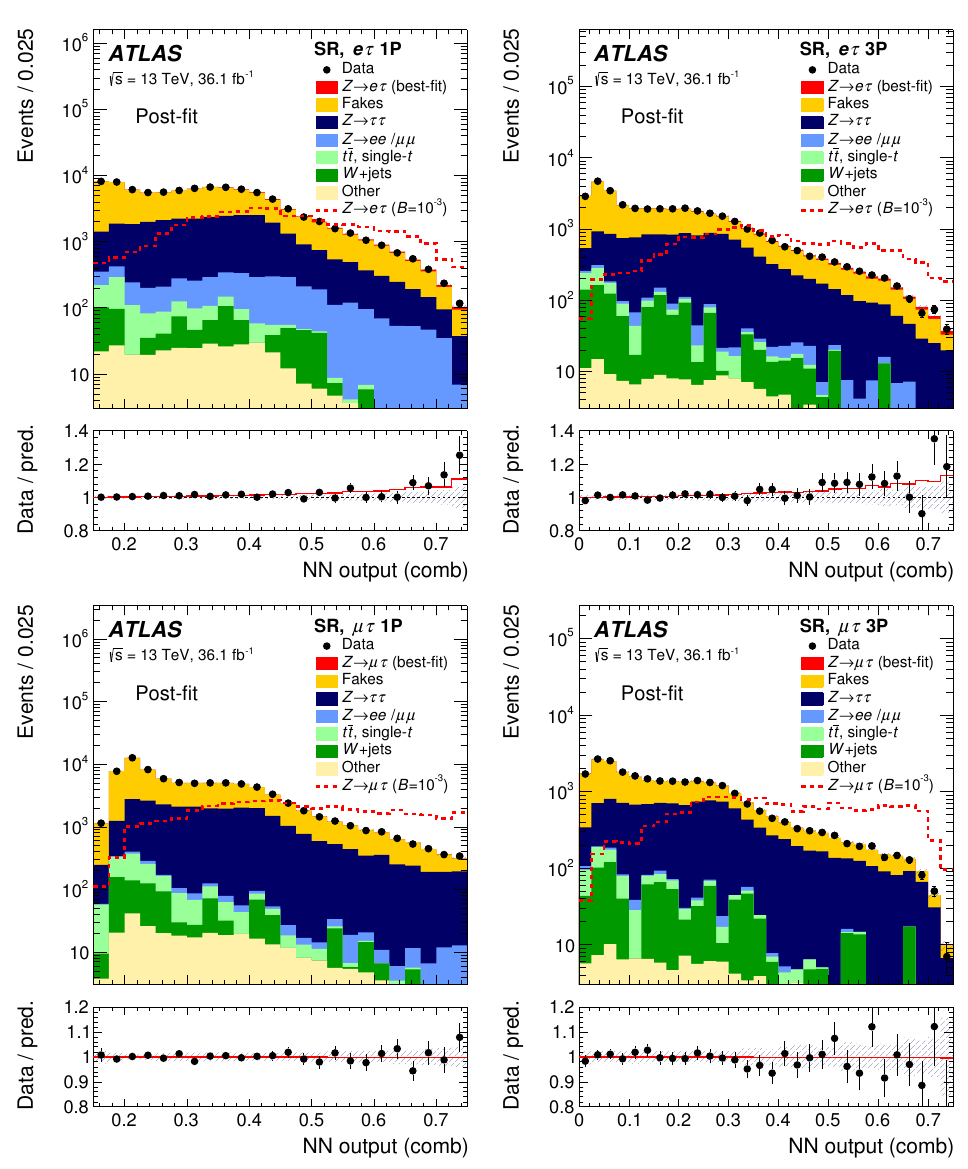
Figure 4: Observed and best-fit expected distributions of the combined NN output